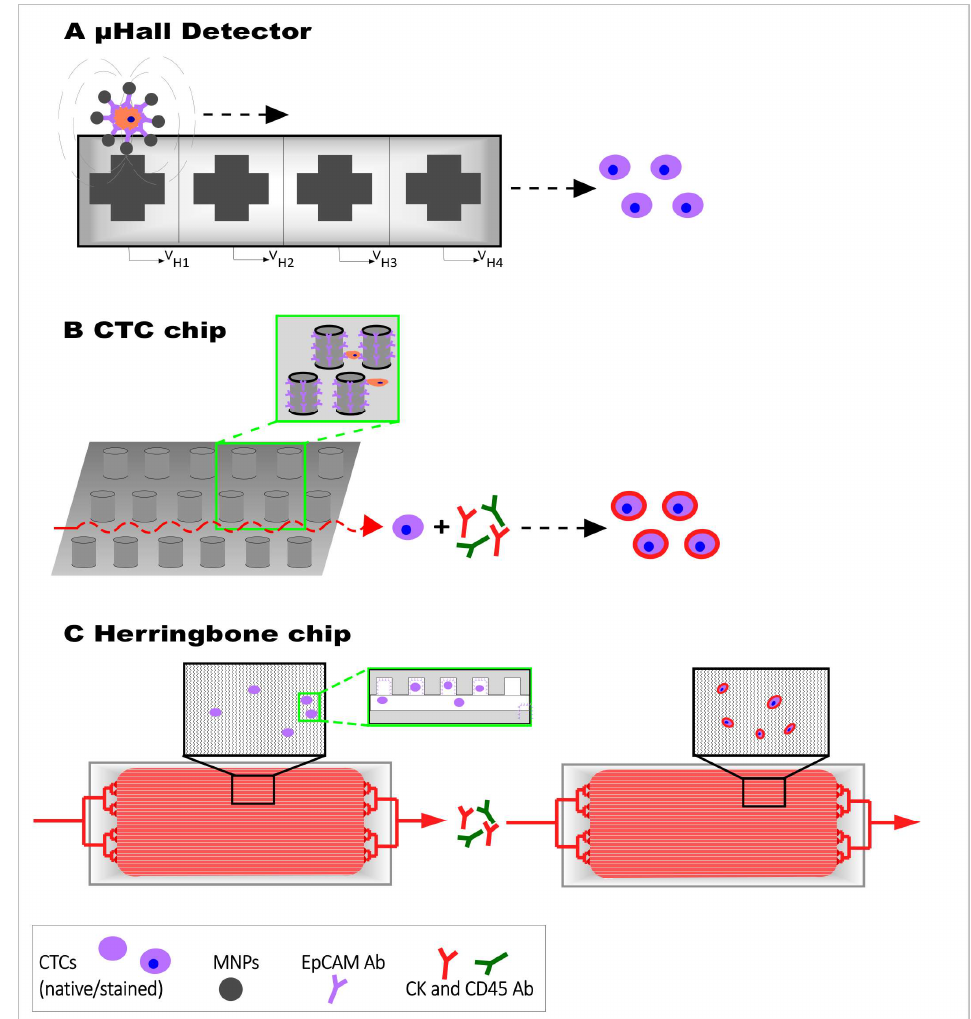
Figure 5. Design of microfluidic chips for CTC detection. Whole blood sample is pushed through the surface of the chip. ( A ) Cells are MNPs-immunolabeled and can be detected via monitoring the magnetic moments of cells in-flow on µHall detection chip. ( B ) CTC chip is coated with a CTC-specific antibody, such as EpCAM, and contains Ab-coated microposts. This system is also used in herringbone chip that contains Ab-coated microchannels ( C ). Captured cells are stained for CK, CD45 and DAPI for identification and enumeration.